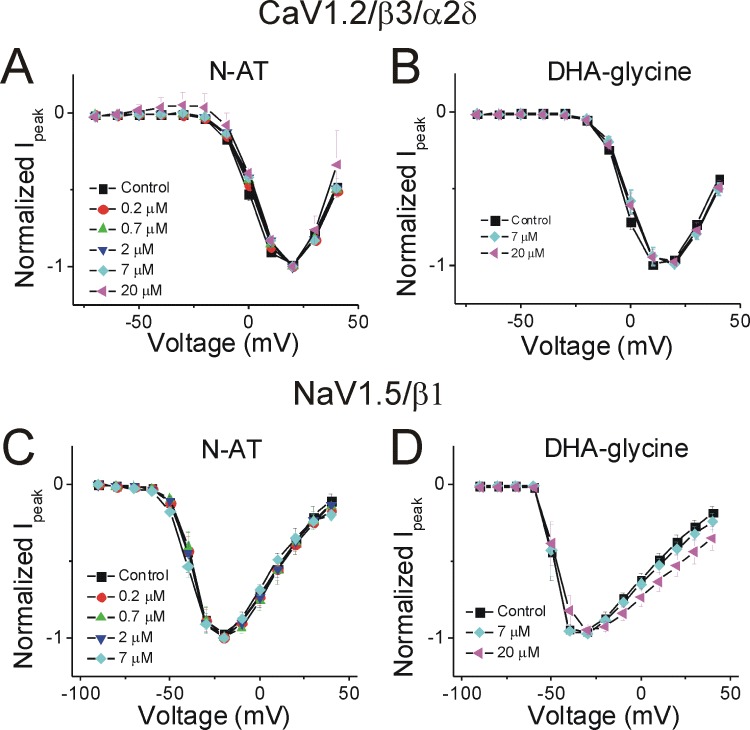
PUFA-induced changes in I/I0 normalized by concentration show no changes in voltage-dependent activation of Cav1.2/β3/α2δ and Nav1.5/β1 channels.(A–B) Voltage-dependent activation of Cav1.2/β3/α2δ in the presence of (A) N-AT (n = 3) and (B) DHA-glycine (n = 3). Peak currents are normalized to each concentration to clearly visualize that there is no shifts in voltage-dependent activation. (C–D) Voltage-dependent activation of Nav1.5/β1 in the presence of (C) N-AT (n = 3) and (D) DHA-glycine (n = 7). Peak currents are normalized to each concentration to clearly visualize that there are no shifts in voltage-dependent activation.